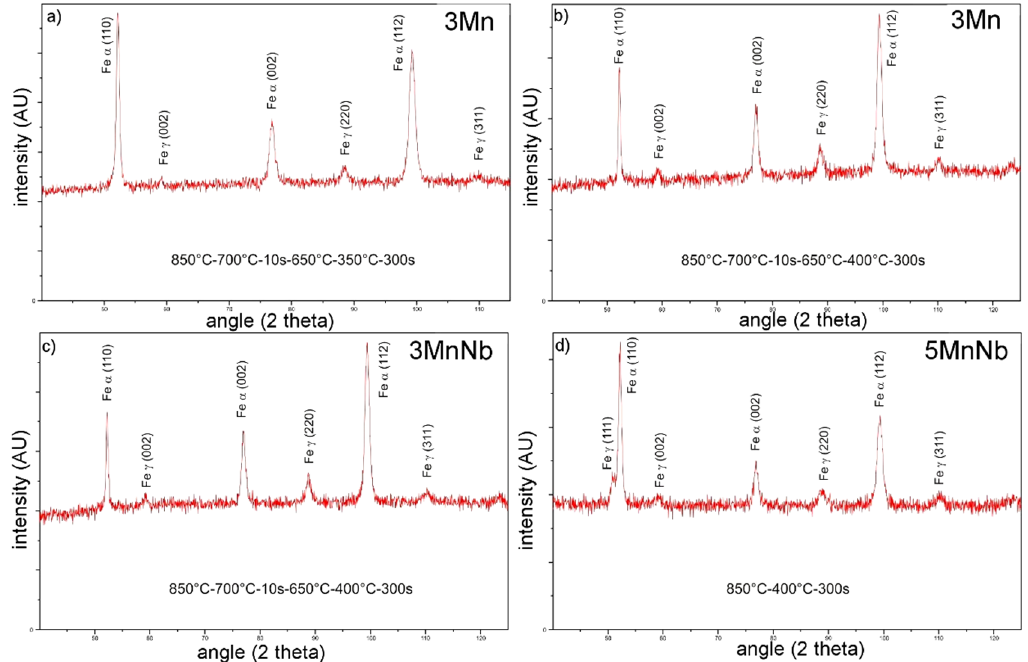
Figure 2. ( a ) X-ray diffraction pattern of 3Mn type steel isothermally held at 350 °C for 300 s; ( b ) X-ray diffraction pattern of 3Mn type steel isothermally held at 400 °C for 300 s; ( c ) X-ray diffraction pattern of 3MnNb type steel isothermally held at 400 °C for 300 s; ( d ) X-ray diffraction pattern of 5MnNb type steel isothermally held at 400 °C for 300 s.